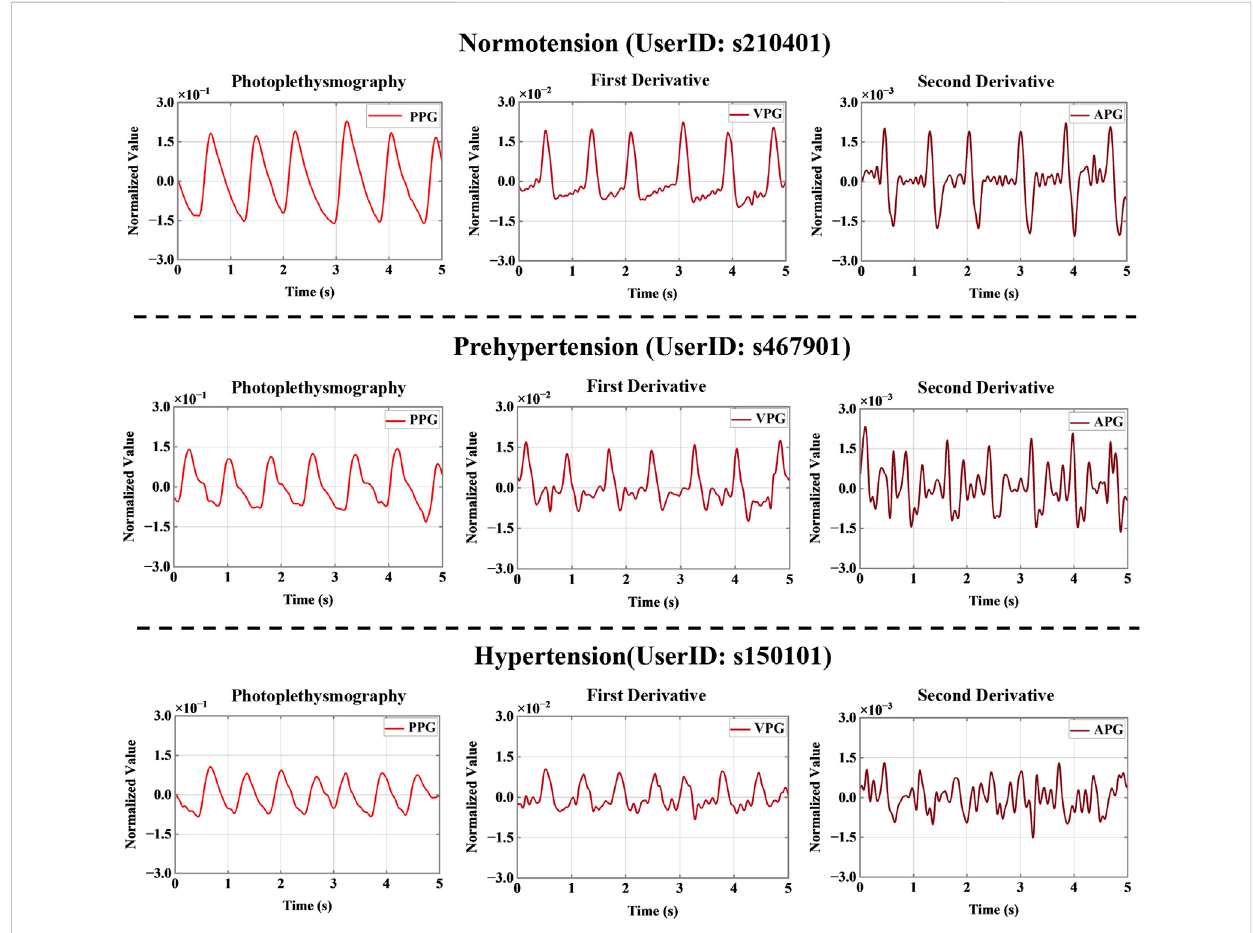
FIGURE 2 Signal derivatives for three different blood pressure categories. Note: PPG, VPG, and APG refer to photoplethysmography, velocity plethysmography, and acceleration plethysmography, respectively.